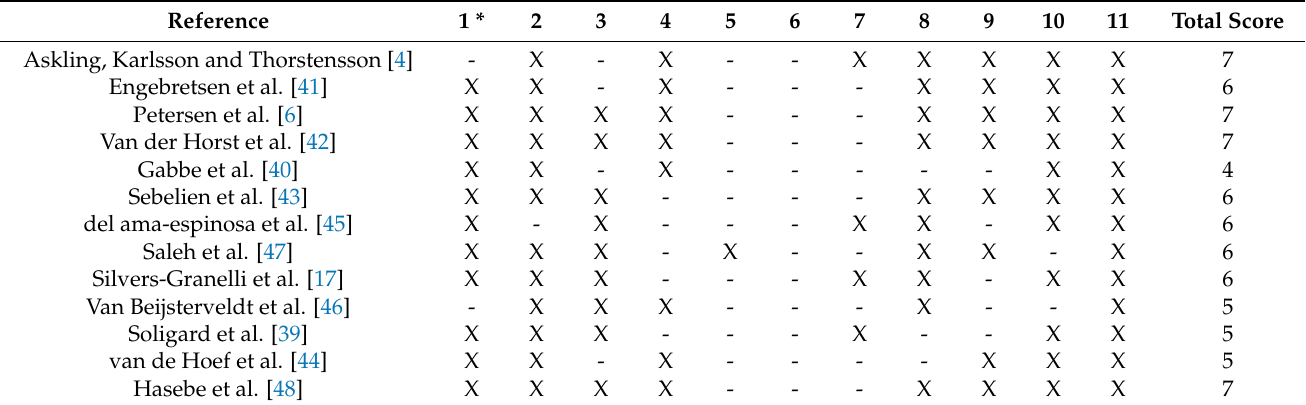
Table 3. The Physiotherapy Evidence Database (PEDro) quality assessment of individual